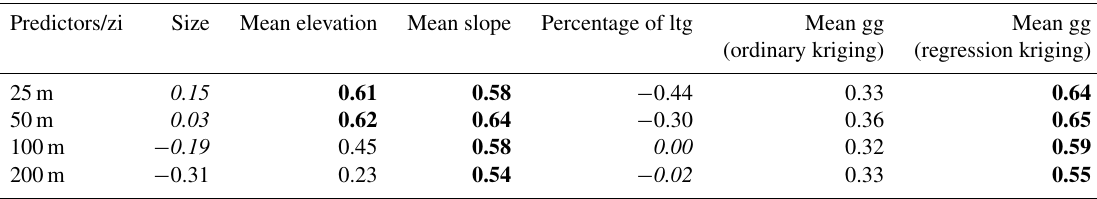
Figure 10. Correlation between far-field conditions and LGD. (a) LGD of lake subsections and mean slope of upslope areas for topographical zone of influence (zi) of 50m; groundwater gradients (GW gradients) are derived from interpolation of measured groundwater levels using regression kriging. (b–d) LGD rates of lake subsections are plotted against the far-field conditions’ mean elevation (b) , mean slope (c) and mean groundwater gradients derived from regression kriging (d) calculated for zi 50m . Table 4. Correlation coefficients ( ρ ) between LGD and far-field predictors calculated for upslope areas in certain topographical zones of influence (zi). ρ values in italic indicate insignificant coefficients ( p value > 0 . 05). ρ values in bold indicate strong significant coefficients ( p value < 0 . 05). gg is the abbreviation for groundwater gradients and ltg the abbreviation for low topographic gradient in direct proximity to the lake